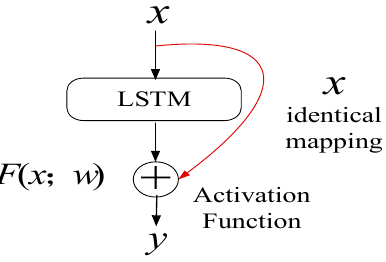
Figure 3. The structure of Residual LSTM.